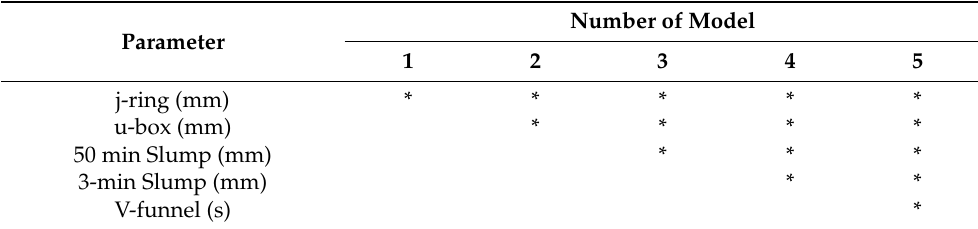
Table 7. Arrangement of the